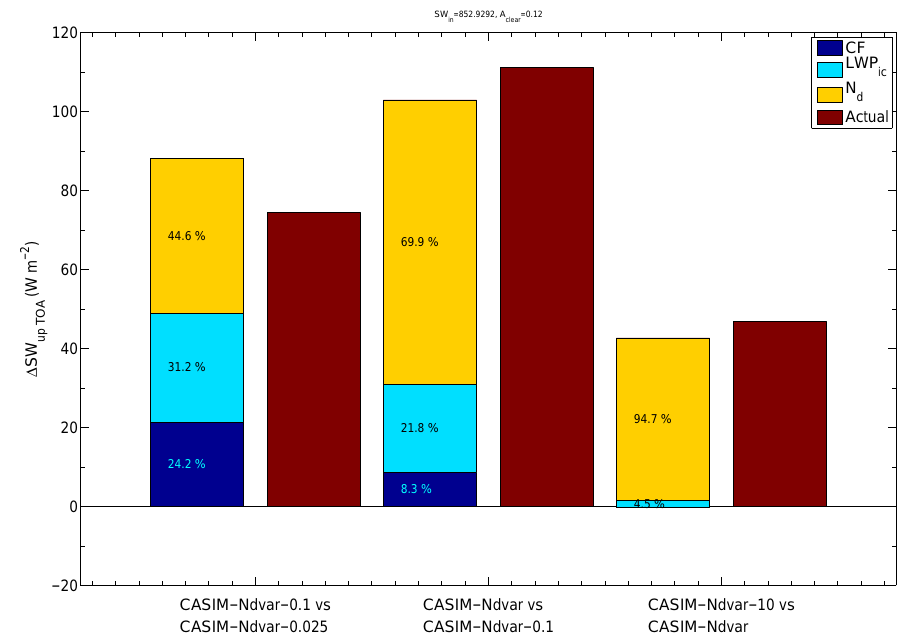
Figure 16. Estimated individual contributions to changes in the shortwave upwelling TOA radiation flux ( (cid:49) SW upTOA ) due to changes in the domain- and time-mean (weighted as for Fig. 15) cloud properties (cloud fraction, f c , in-cloud LWP, LWP ic , and droplet number concentration, N d ; see the legend for the colour labelling) using an analytical formula for scene albedo. Changes in SW upTOA are estimated between a given run in Fig. 15 (Run i ) and the run with the next highest aerosol concentration (Run i + 1 ) by replacing one cloud property of Run i with that from Run i + 1 , i.e. for the f c response, (cid:49) SW f runs indicated by the x -axis labels. The percentage that each cloud property contributes to the sum of the absolute changes is shown in the individual bars, e.g. the cloud fraction percentages are given by 100 × (cid:49) SW f the actual change in SW from the model